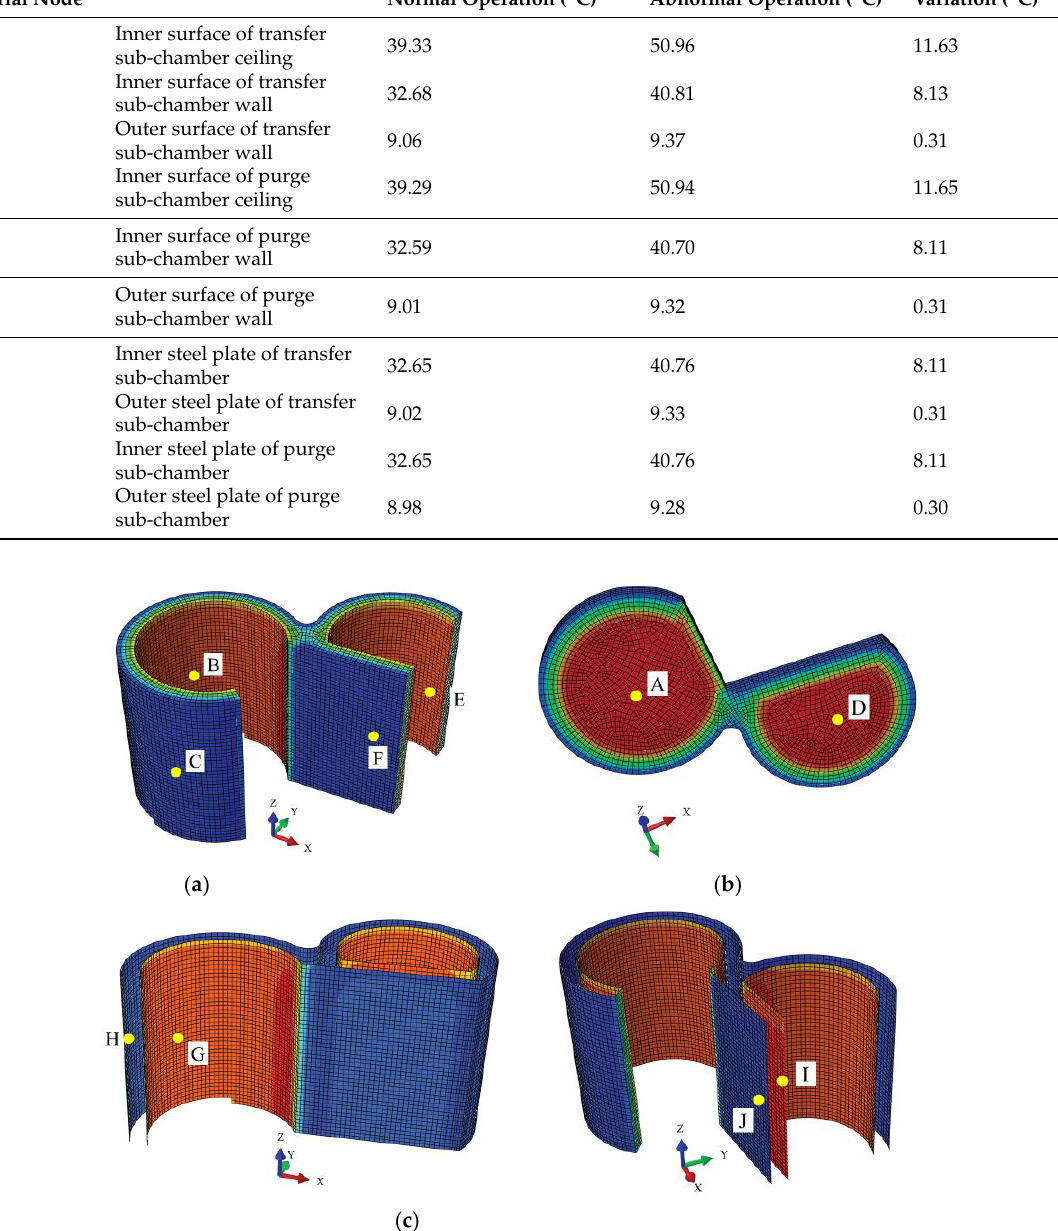
Figure 6. Schematic diagram of a temperature field node in the TPC. ( a ) Surface of transfer sub-chamber wall; ( b ) Surface of transfer sub-chamber ceiling; and ( c ) Steel plate of transfer sub-chamber .